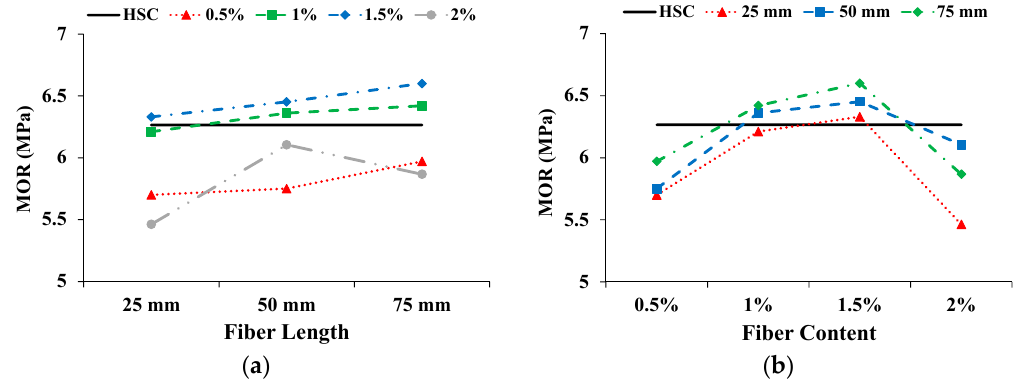
Figure 13. Influence on MOR: ( a ) Fiber length; ( b ) Fiber content.